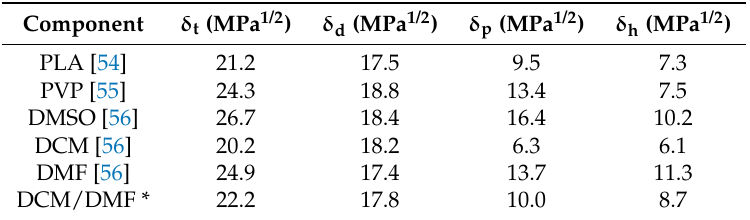
Table 2. Hansen solubility parameters.